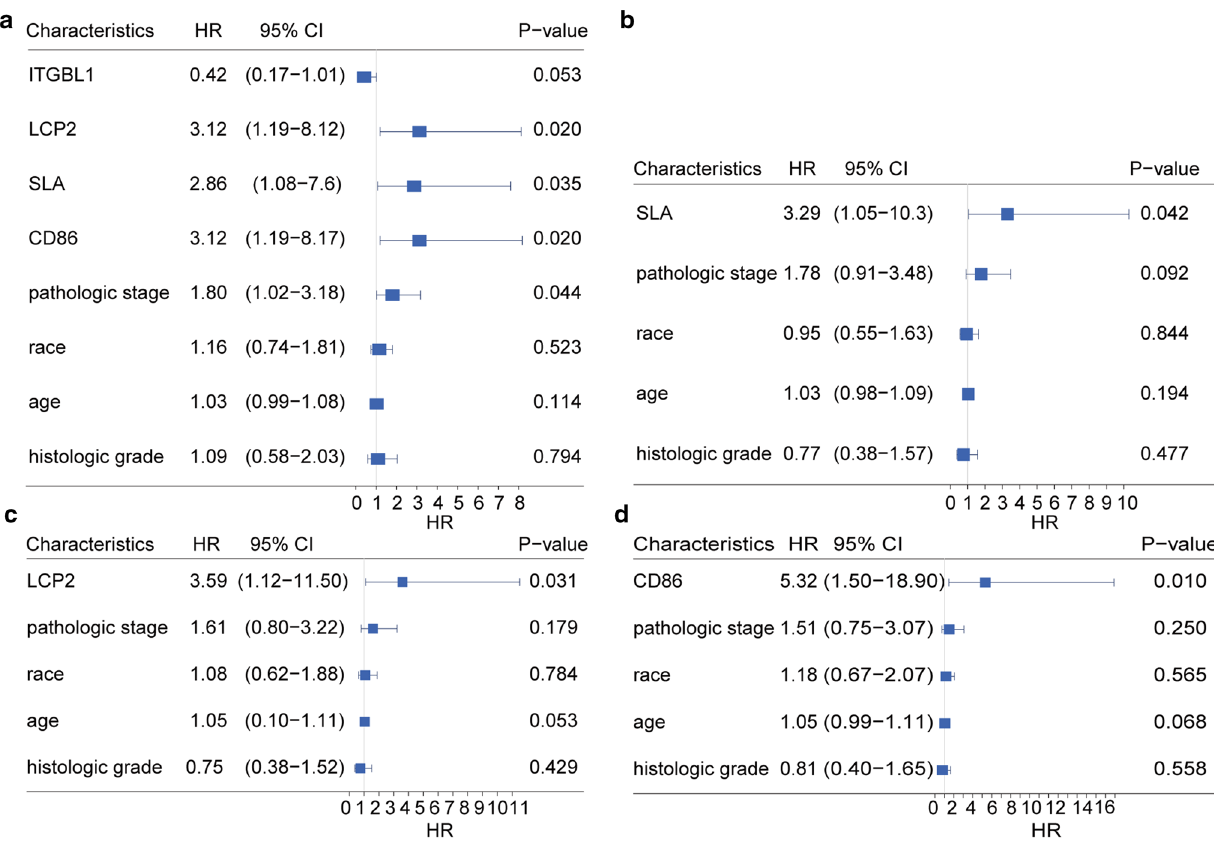
Fig. 7 Univariate and multivariate cox proportional hazard regression analysis of three core